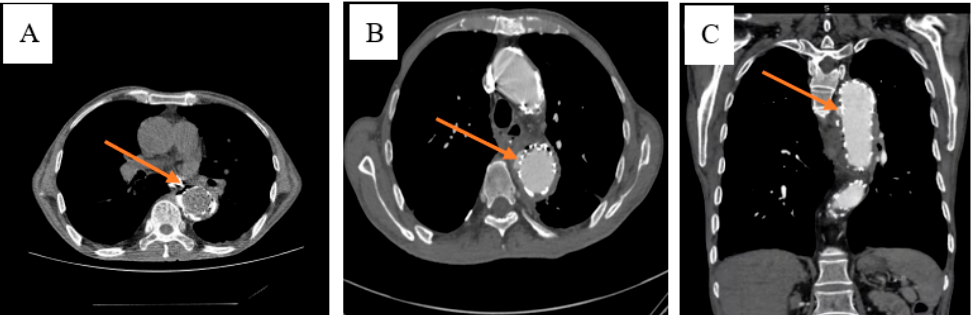
Figure 5. To clarify the cause of the patient’s gastrointestinal haemorrhage, the thoracic aortic CTA ex-amination revealed changes after the aortic arch-descending aortic stent implantation and a little contrast agent leaked from the outer edge of the descending aortic stent at the level of the flat chest 6–7 vertebral bodies. We saw the obvious changes after the titanium clip repair ( A ), and at the same time, there was blood leakage outside the descending thoracic aorta ( B , C ).